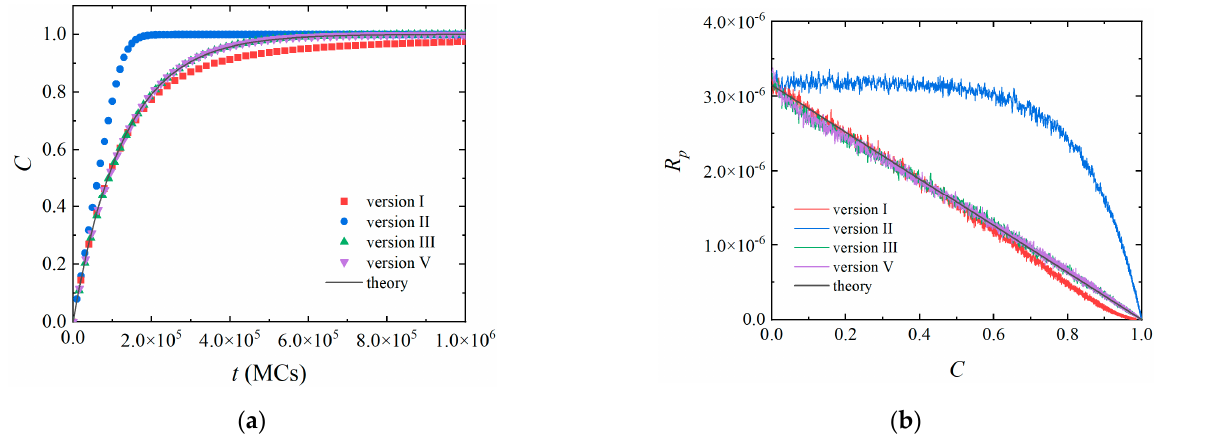
Figure 3. ( a ) Monomer conversion C as a function of simulation time. ( b ) Polymerization rate R p as a function of monomer conversion C . The parameters are the same as those in Figure 2.